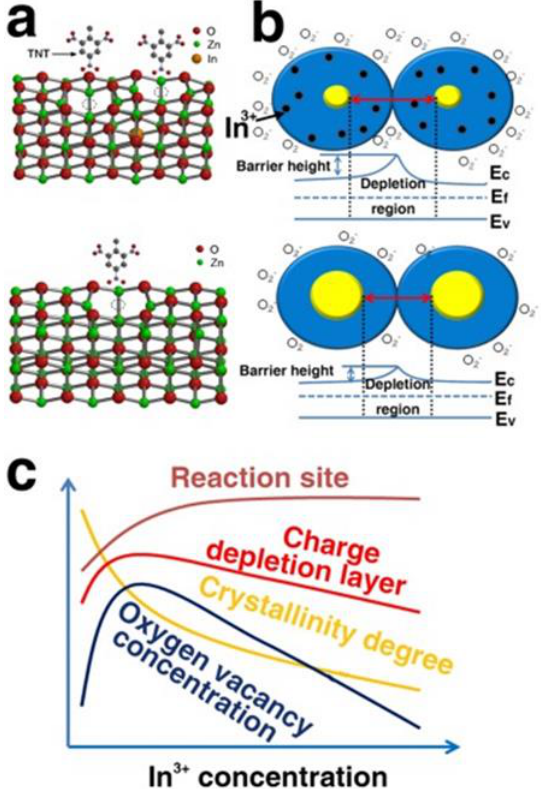
Figure 10. ( a ) Schematic representations of the 5% In-doped ZnO (upper part) and pure ZnO NPs crystal structures (lower part). ( b ) Schematic illustration of sensing on the surface of 5% In-doped ZnO (upper part) and pure ZnO NPs (lower part), and ( c ) possible effects of In 3+ concentration on the reaction site, the oxygen vacancy concentration, crystallinity degree and charge depletion layer depth. Reprinted with permission from [59].